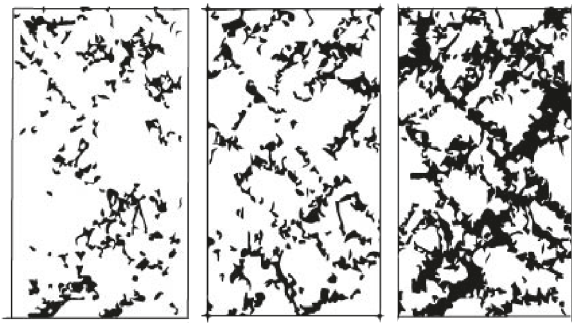
Figure 1: Effects of confining pressure on soil failure morphology (from left to right, the confining pressure is 0 kPa, 10kPa, and 100kPa), from Liu